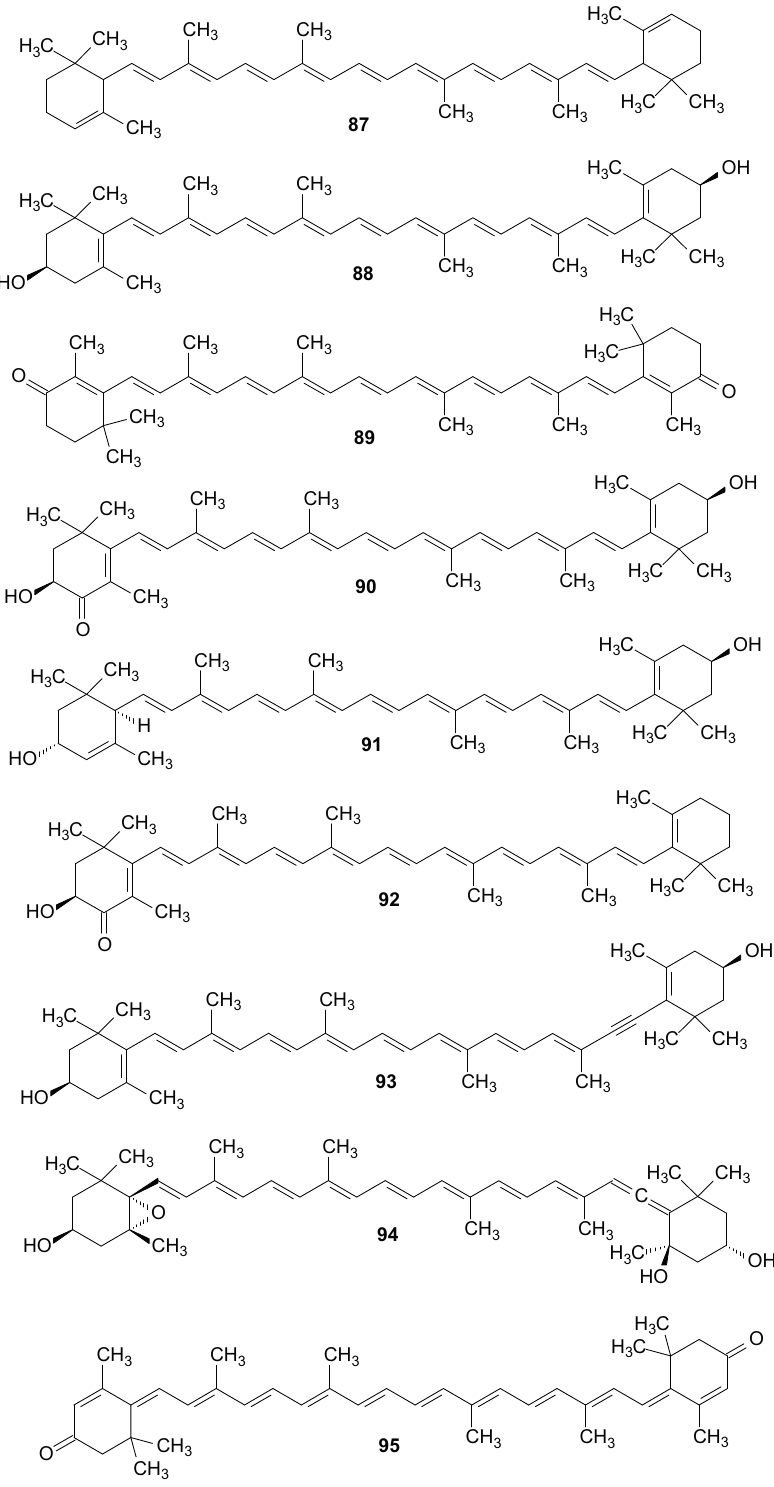
Figure 6. Chemical structures of other compounds: carotenoids of Ramalina species of lichenized